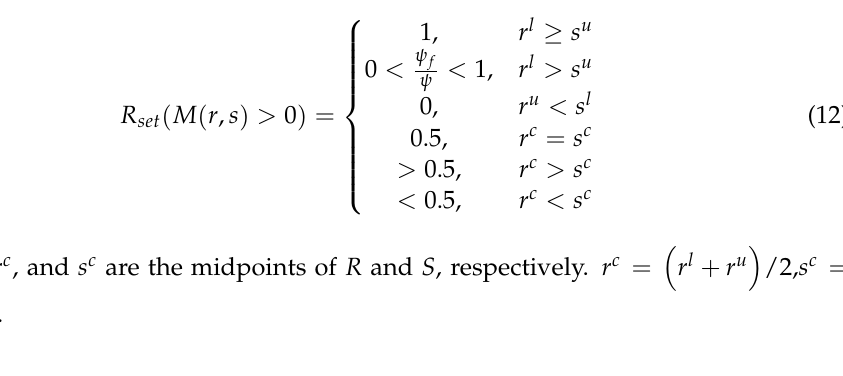
s = s l , and s = s u . ψ f denotes the part of the region ψ overlapping with the reliability